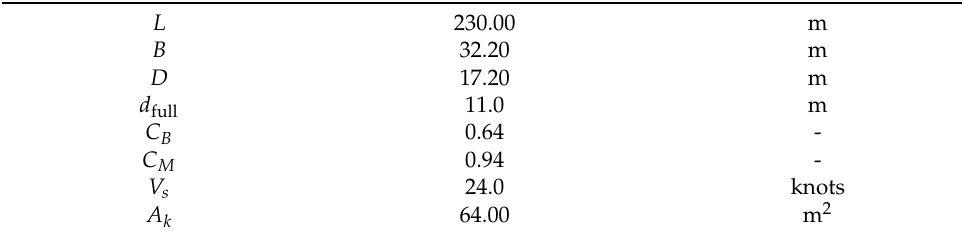
Table 23. Principal dimensions of the KCS container ship.